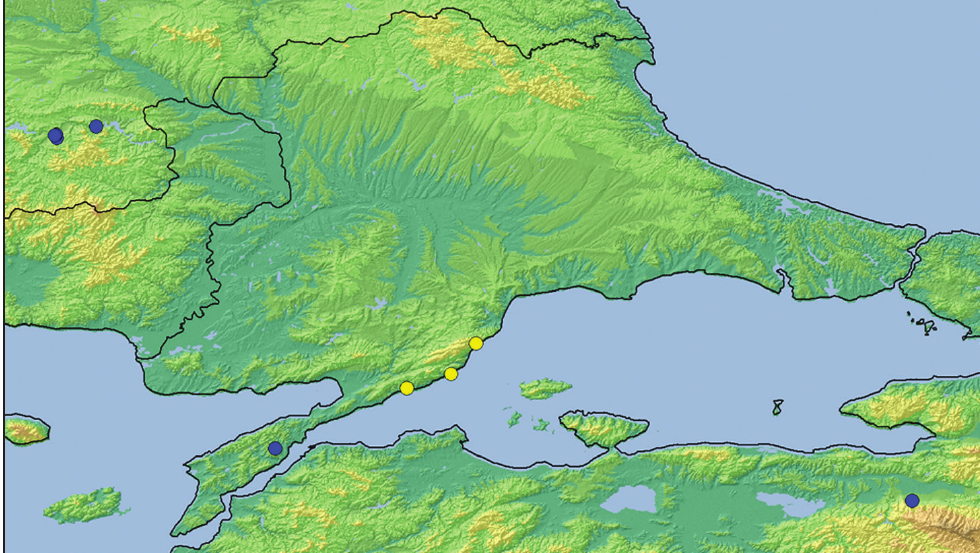
Figure 4. Distribution map of Theresimima ampellophaga in the Thrace Region with new data (yellow dots). Rh. ( Rh. ) pruni was found for the first time in Turkey. That was possible due to the application of the sex attractants. Rh. ( Rh. ) pruni and Rh. ( W. ) amasina were recorded in the same